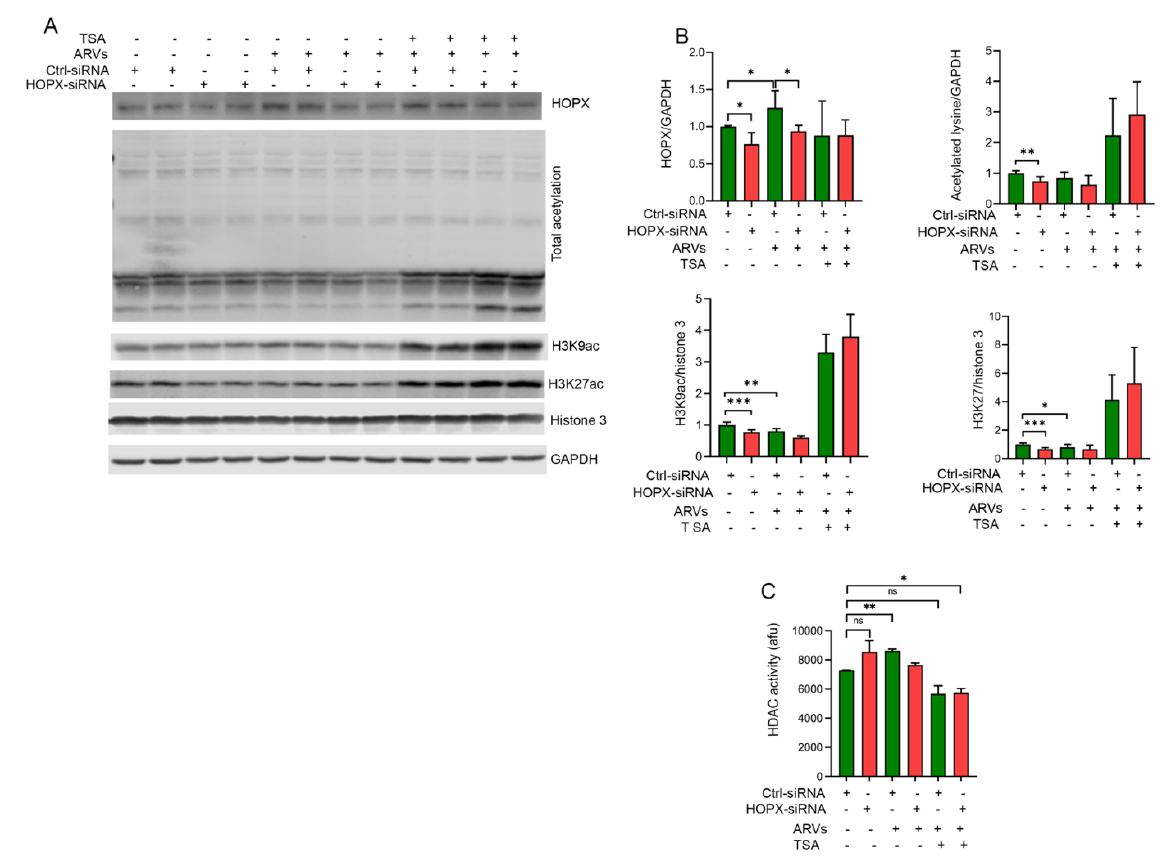
Figure 6. Downregulation of HOPX may cause aberrant cellular lysine acetylation. HOPX expression was knocked down using HOPX-siRNA in NRVCs for 30 h and then treated with ARVs and TSA for another 24 h. Control cells were treated with DMSO. ( A ) Western blot images showing expression of HOPX, total cellular acetylation, H3K9ac, and H3K27ac in HOPX-siRNA-treated cardiomyocytes. Furthermore, Western blots show that TSA treatment restores the total and H3K9, H3K27 acetylation in Hopx-siRNA- and ARV-treated cardiomyocytes. ( B ) Graphs show quantification of Western blot images of HOPX, total acetylated lysine, H3K9ac, and H3K27ac. Values are presented as means ± SDs from three biological replicates and two technical replicates each time. ( C ) Graph shows deacetylase activity of the HDAC in cardiomyocytes treated with HOPX-siRNA and ARVs or DMSO ( p -value, ns = not significant; *, <0.05; **, <0.01; ***, <0.001). NRVCs were treated with the HOPX-siRNA or Ctrl-siRNA for 30 h and then treated with the ARVs and TSA for another 12 h.